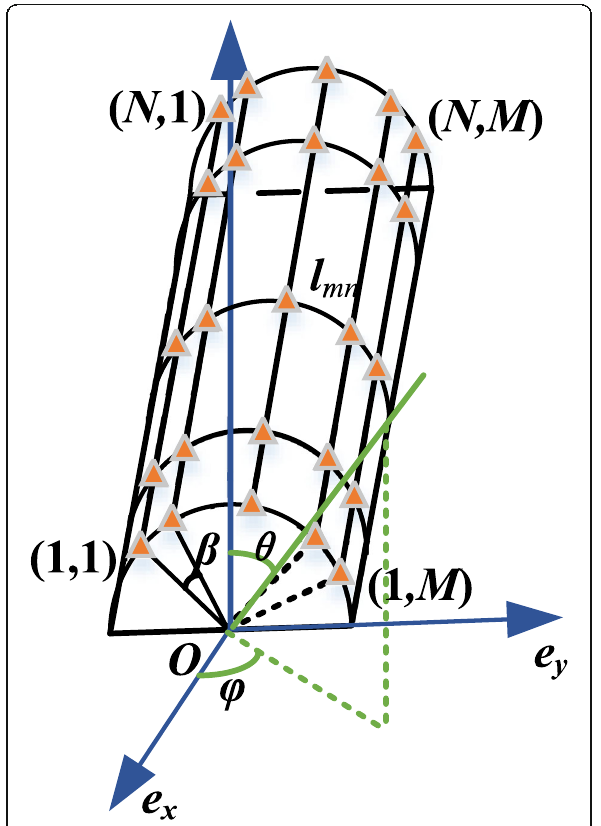
Fig. 3 The cylindrical conformal array consisting of M x N electromagnetic vector